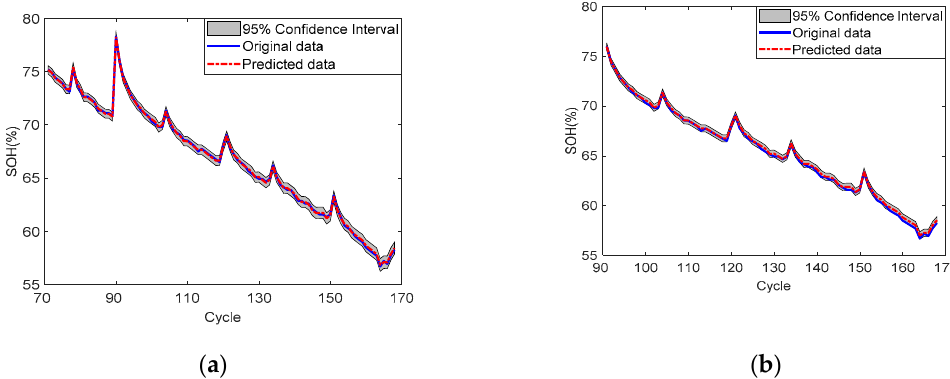
Figure 7. SOH prediction results of battery No. 5: ( a ) SP = 71; ( b ) SP = 91.